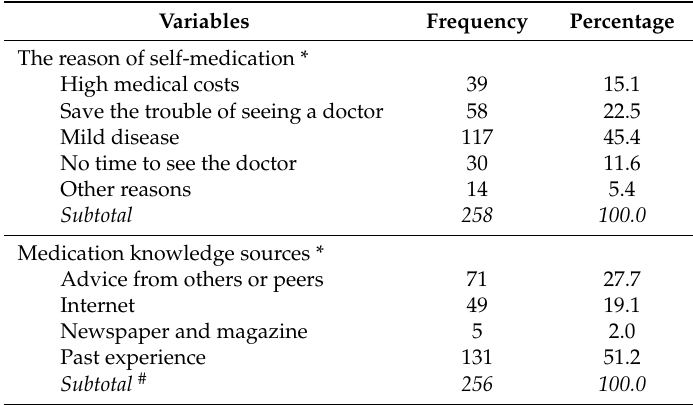
Table 2. The reason and source of knowledge for self-medication.